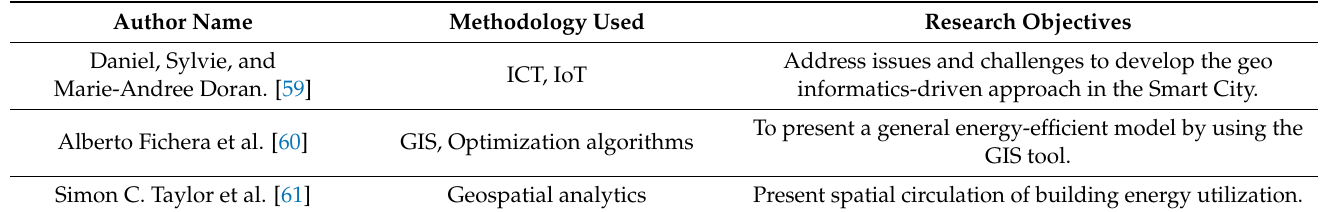
Table 5. Research articlesbased on geospatial data